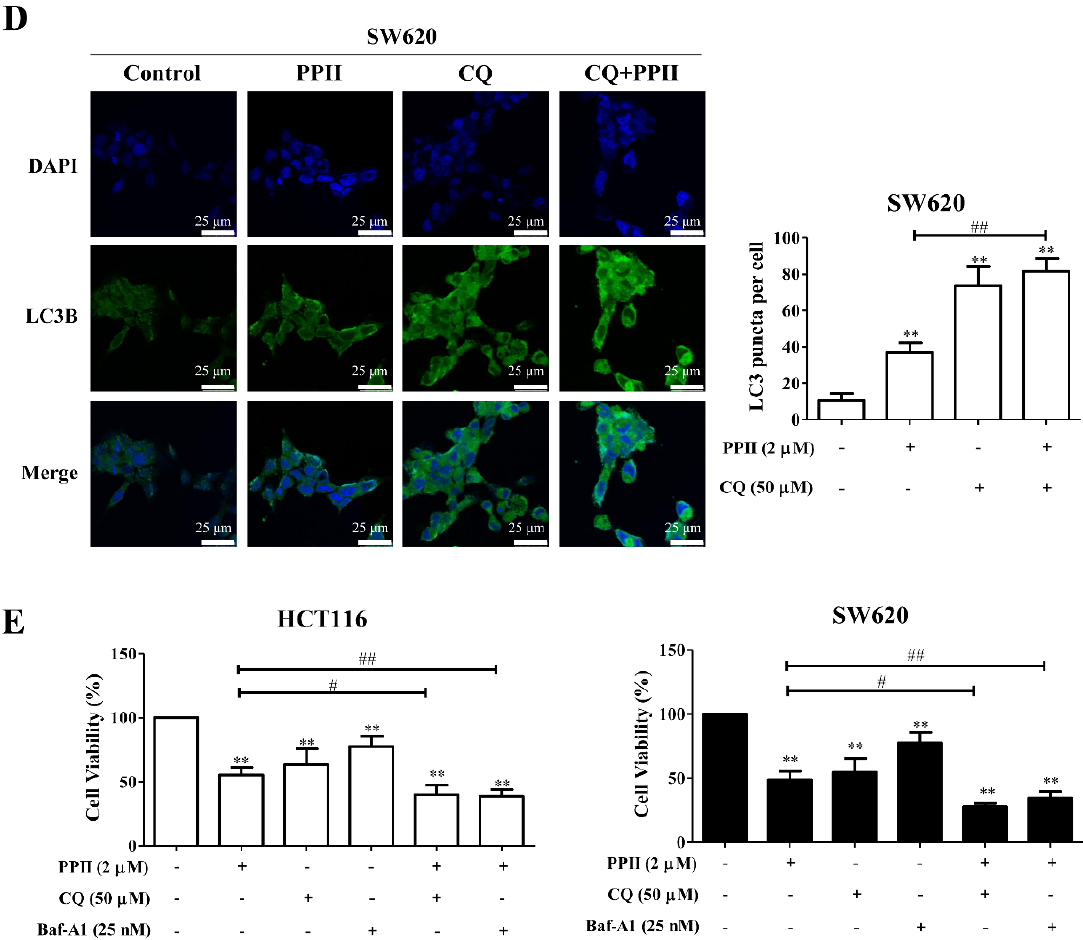
Figure 4. PPII induces autophagy in CRC cells. ( A ) PPII upregulated the protein level of LC3B − II. Representative immunoblotting bands are presented in the left panels, and the quantitative results of the LC3B-II are shown in the right panels. ( B , C ) The protein level of LC3B − II in the PPII − plus-CQ − or Baf − A1 − treated melanoma cells were examined using Western blotting. ( D ) PPII increased the cytoplasmatic LC3B puncta in the SW620 cells. The cells were treated with or without 2 µ M of PPII in the presence or absence of CQ (50 µ M) for 24 h. The LC3B puncta were visualized using immunofluorescence analyses. The representative images are photographs taken using a confocal microscope. The scale bar = 10 µ m. Representative images (left panels) and the average numbers of green LC3B dots per cell (right panel) are shown. ( E ) The viability of the PPII − plus − -CQ-treated (50 µ M) or Baf − A1 − treated (25 nM) CRC cells was determined using MTT assays. The data are presented as means ± SD, with n = 3. ** p < 0.01 vs. the vehicle control; # p < 0.05 and ## p <